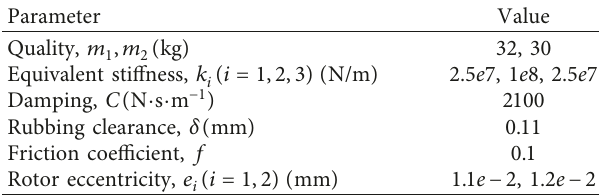
Table 1: Main parameters of the